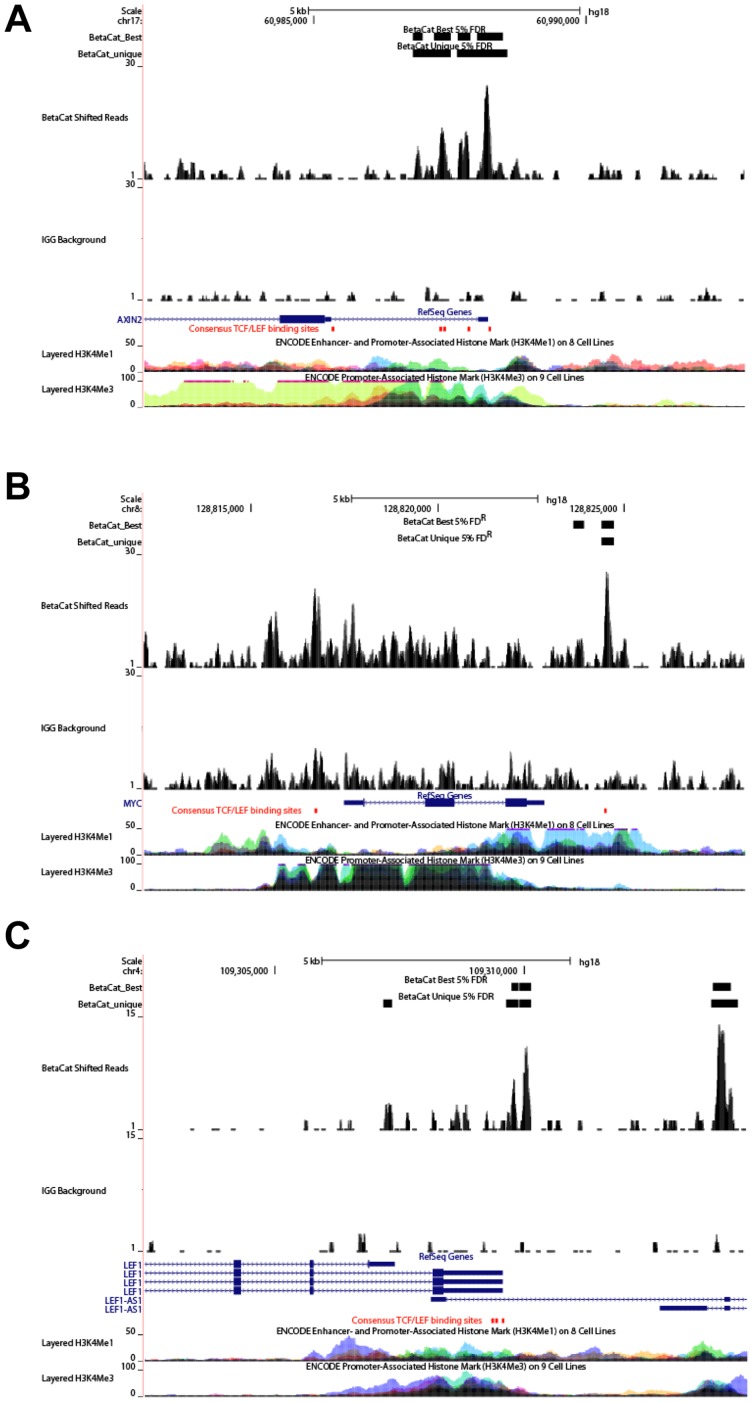
Visualization of the CTNNB1 binding peaks in AXIN2 (A), MYC (B), and LEF1 (C) genes.Shown are results for CTNNB1 and IgG distributions on Ref-seq gens. Red boxes indicate the positions of consensus TCF/LEF-binding motifs. H3K4me1 and H3K4me3 domains from multiple Encyclopedia of DNA Elements (ENCODE) cell lines are shown as references for enhancer/promoter and promoter regions, respectively.